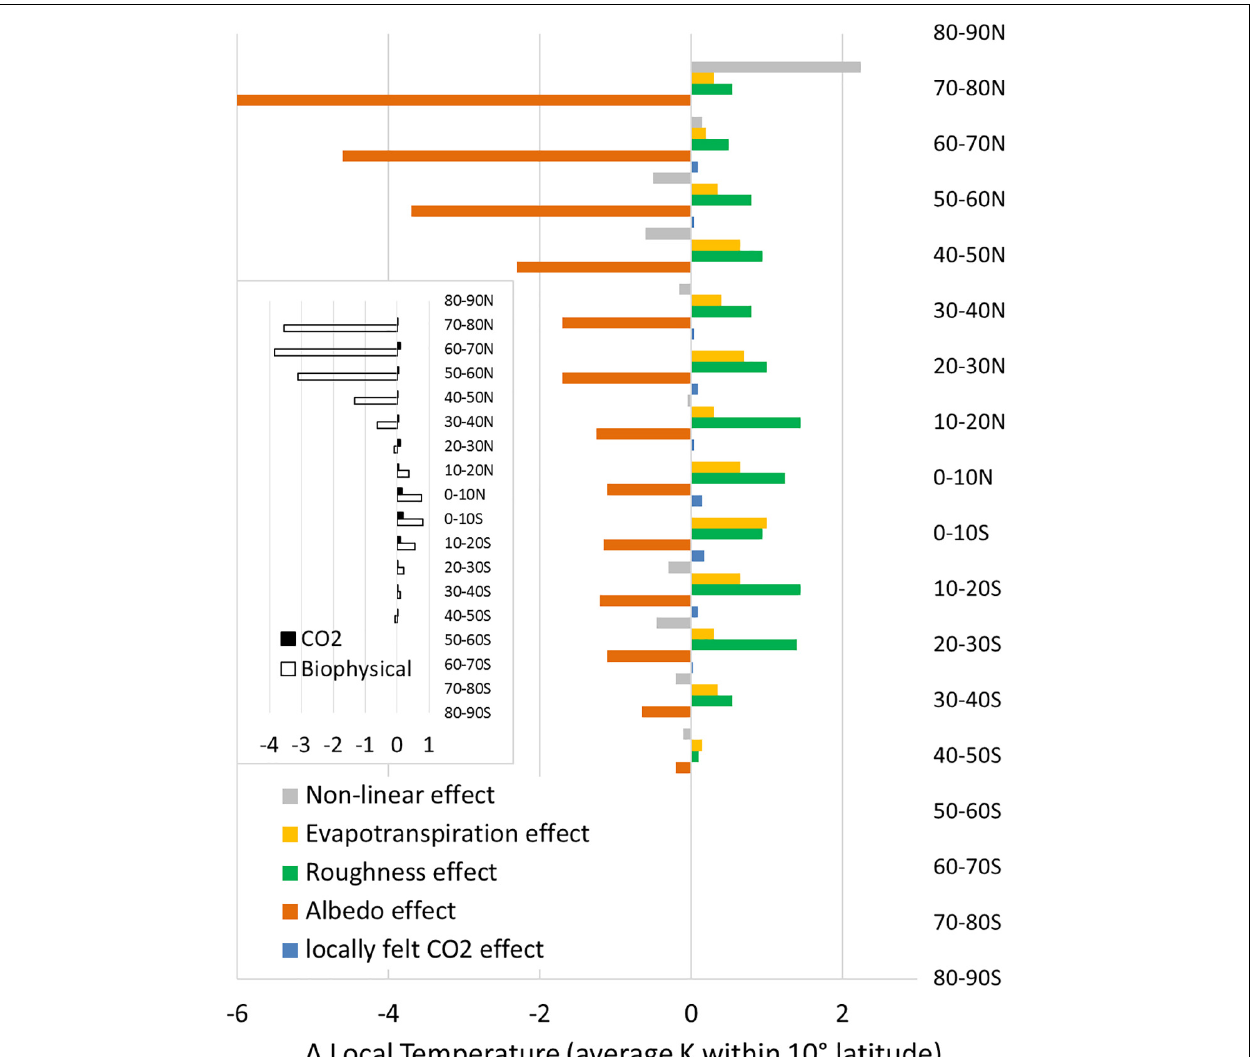
FIGURE 4 | Effect of complete deforestation on local annual temperature by climate factor, averaged across the land surface within a 10 ◦ latitudinal band. Complete deforestation was implemented globally and analyzed by 10 ◦ latitudinal bands (Davin and de Noblet-Ducoudré, 2010). The CO 2 effect was determined from total aboveground biomass in each 10 ◦ band after Walker et al. (2020) and scaled by CERA-derived sensitivity by latitude. Inset distinguishes the sum of all local biophysical effects from local CO 2